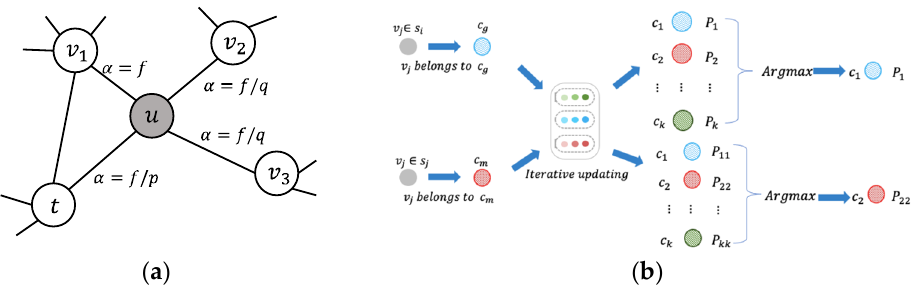
Figure 2. Node embedding process. ( a ) Random walk search strategy; ( b ) Node representation learning.